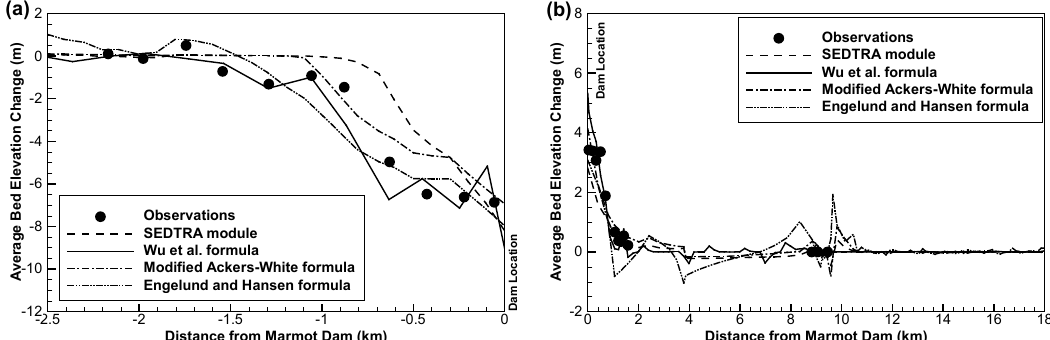
Fig. 3 Comparison of 1-year bed changes using four sediment transport rate